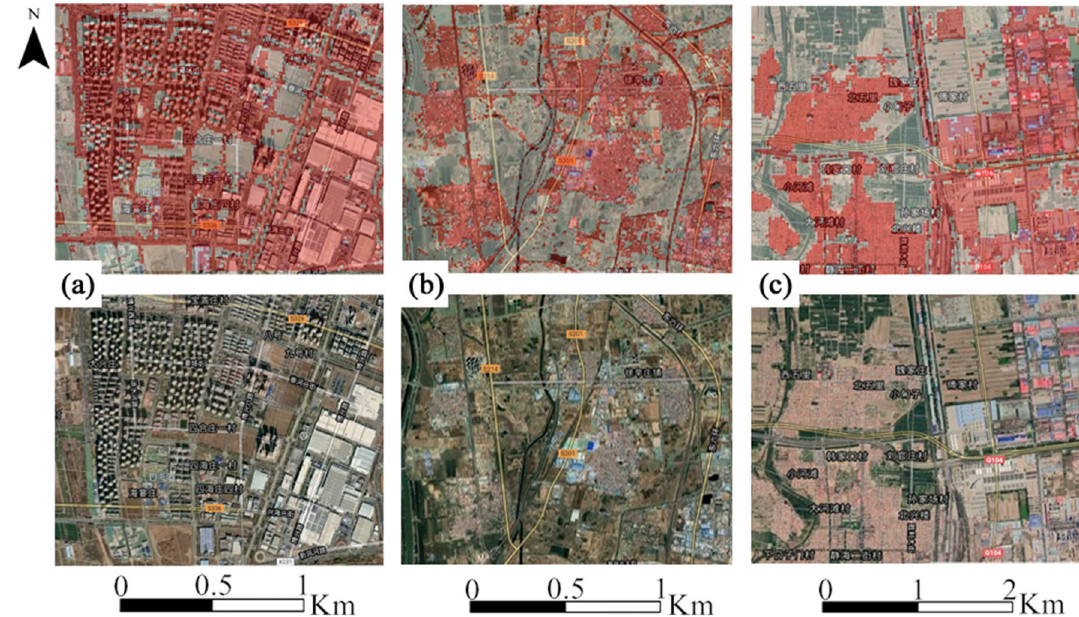
Figure 4. Comparison of local areas before and after classification of satellite images, which were obtained from Landsat-8 OLI images during June to September in 2018. The translucent red part of the first row of the figure shows the extracted built-up land. Map data: Google, ©2021 CNES/Airbus, Landsat/Copernicus, Maxar